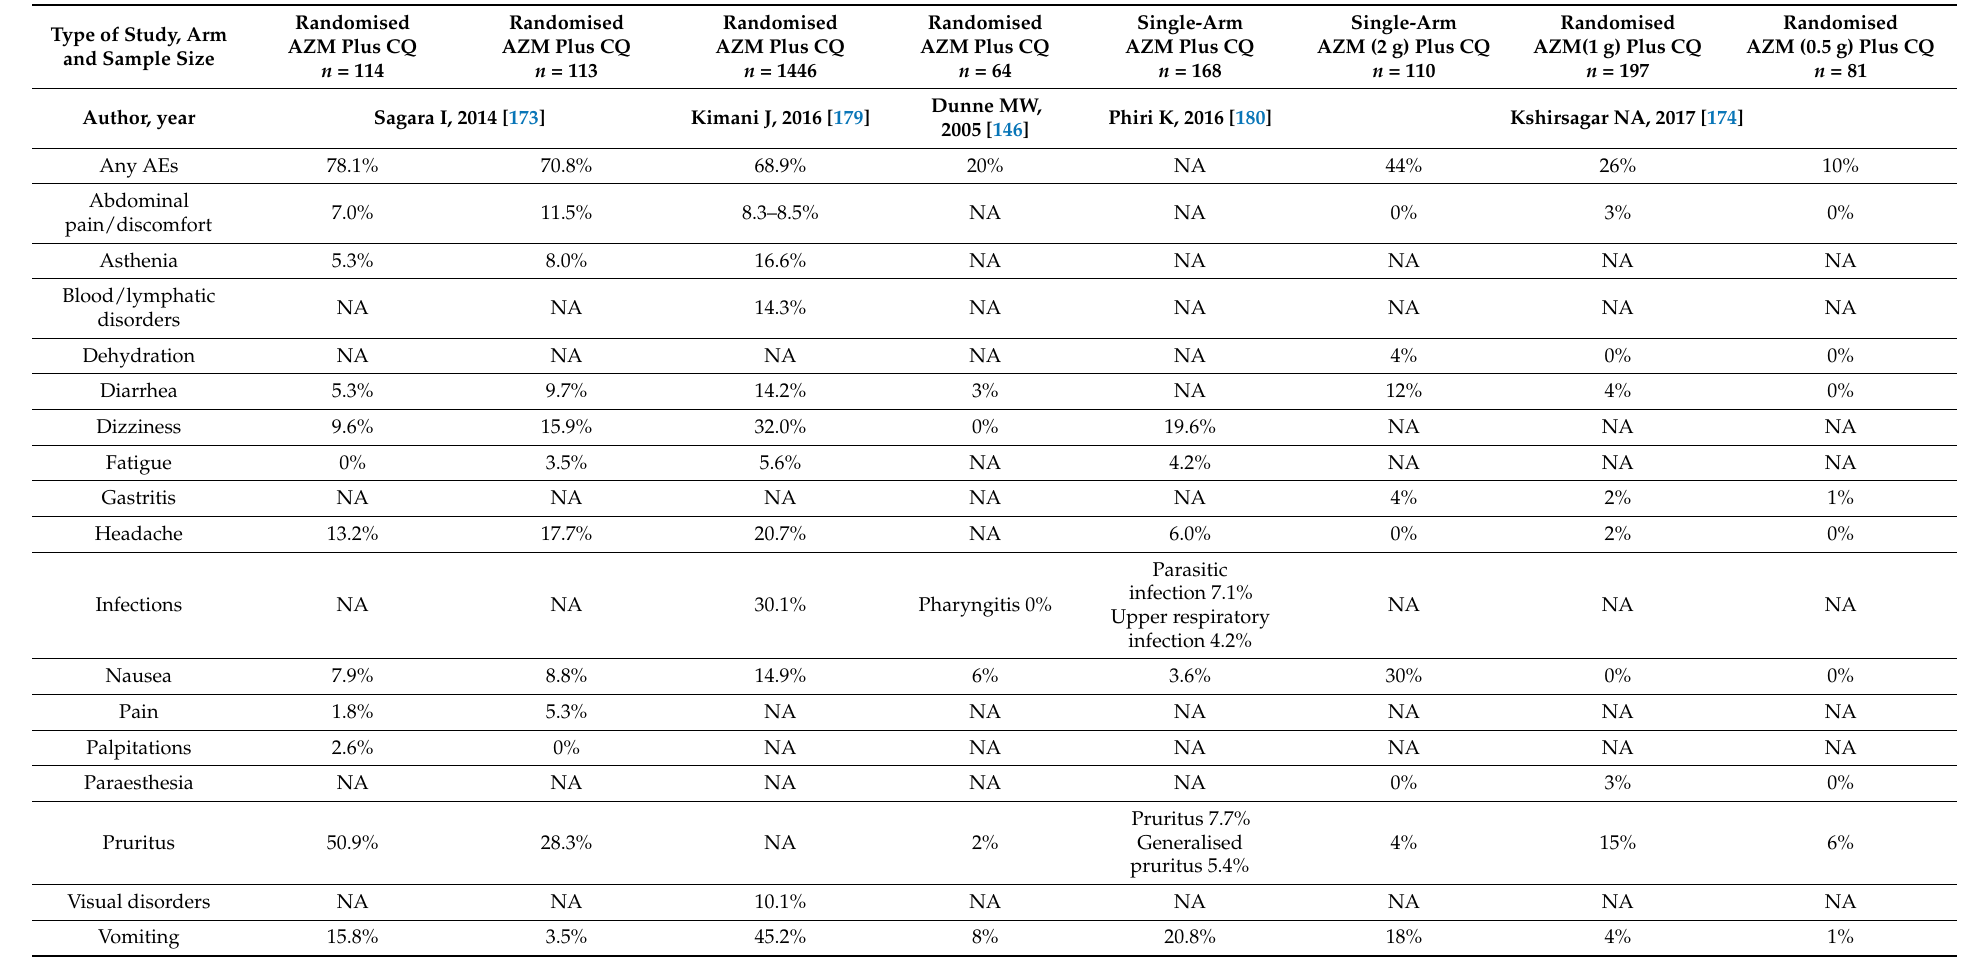
Table 4. Summary of studies: early adverse events of CQ in combination with AZM in patients affected by malaria or who received prophylactic